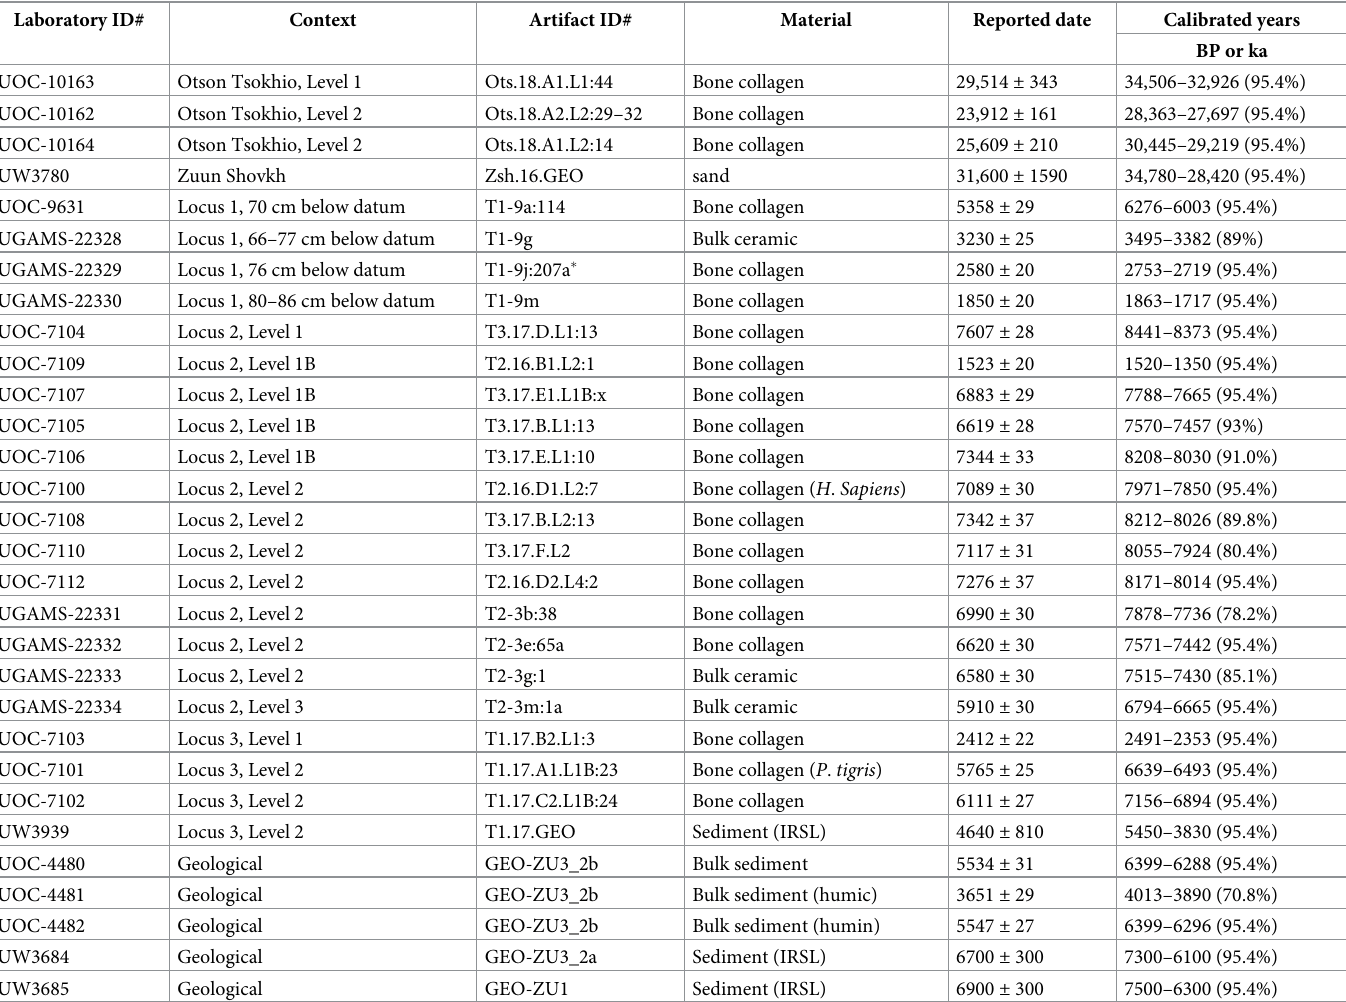
Table 2. Results of luminescence and radiocarbon dates for Zaraa Uul. Calibration was performed using OxCal v4.4.2 [31] and the IntCal20 calibration curve [46]. Laboratory